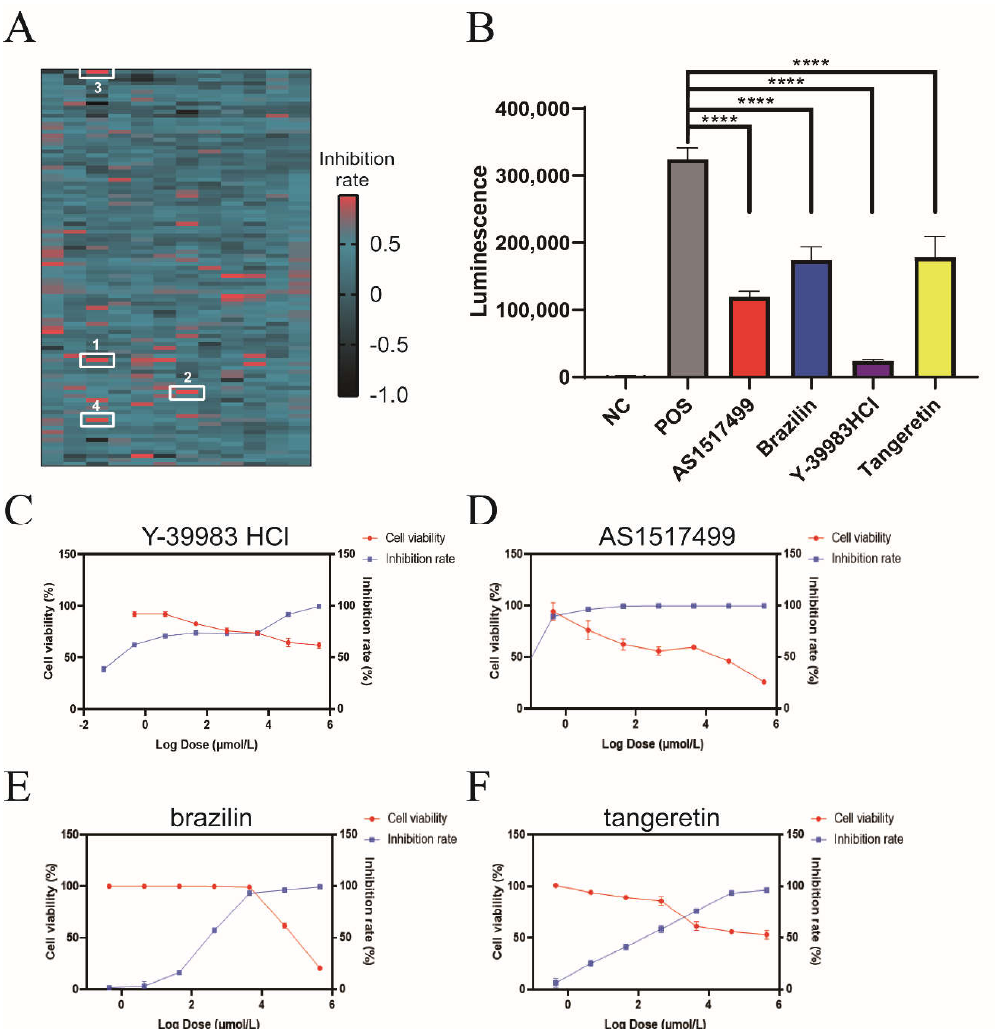
Figure 2. High-throughput compound screening by NanoBiT assay. ( A ) Composite heat map of 1177 compounds screened by NanoBiT assay. HEK293T Cells were co-transfected with plasmids CLV (Vpu with C-terminal LgBiT) and NSB (BST-2 with N-terminal SmBiT). Compounds with a final concentration of 10 μmol/L were added 4 h later. The heat map is drawn from the calculated inhibition rate. AS1517499 (1), Y-39983 HCl (2), brazilin (3) and tangeretin (4) were labeled with white rectangles. ( B ) HEK293T cells were co-transfected with plasmids CLV and NSB and then treated with Y-39983 HCl, braz- ilin, tangeretin, or AS1517499 (10 μmol/L), respectively. Luciferase activities were measured using a multilabel reader. ****, p < 0.0001 vs. postive control group. Dose-dependent curves of the inhibition rate and cell viability of HEK293T cells treated with ( C ) Y-39983 HCl, ( D ) AS1517499, ( E ) brazilin, or ( F ) tangeretin. Values presented are the mean ± SD of three replicates.